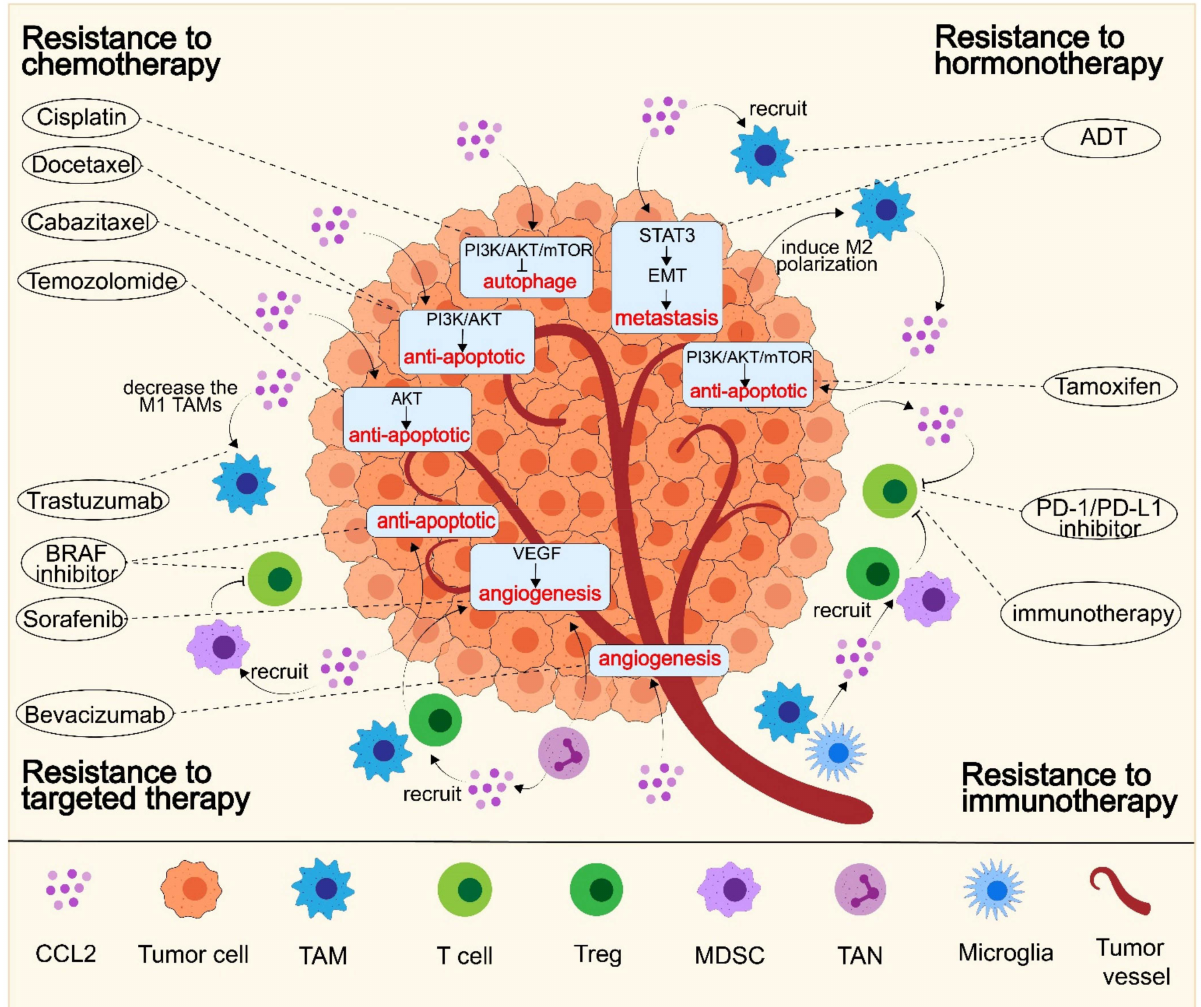
Figure 2. The role and mechanism of CCL2 in the development of anticancer resistance.